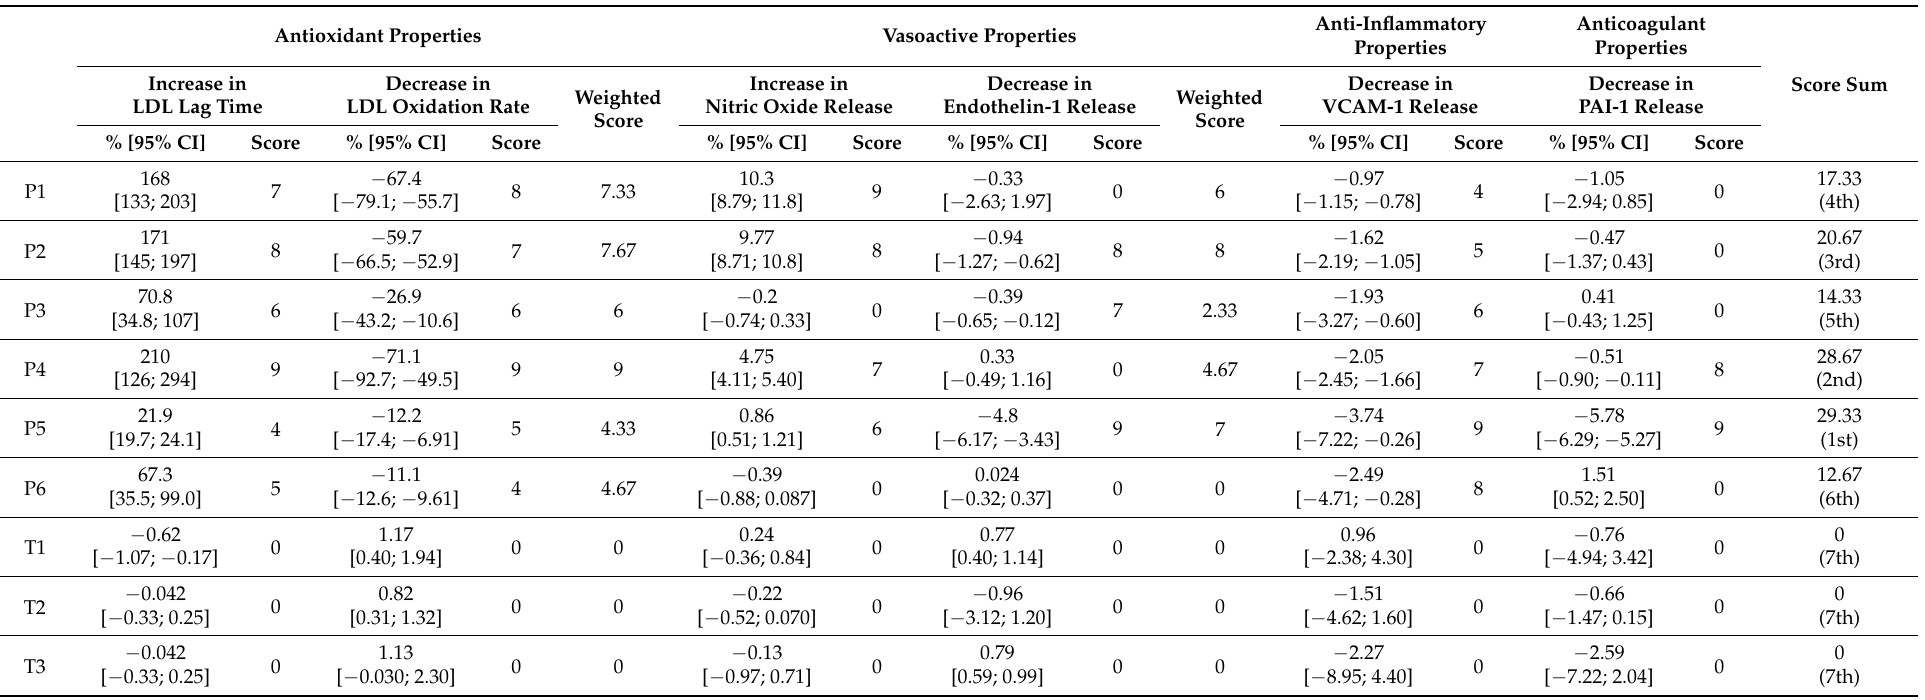
Table 1. Dose-dependent associations of phenolic (0.05–10 µ mol/L) and triterpenic solutions (0.001–10 µ mol/L) with in vitro bioactive properties 1